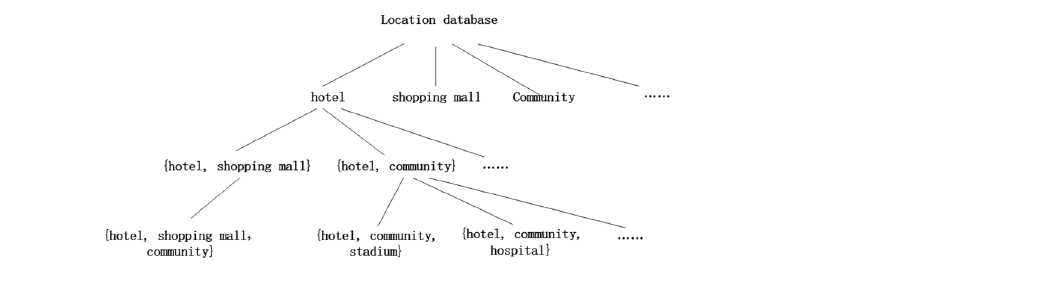
Figure 1. Position trie